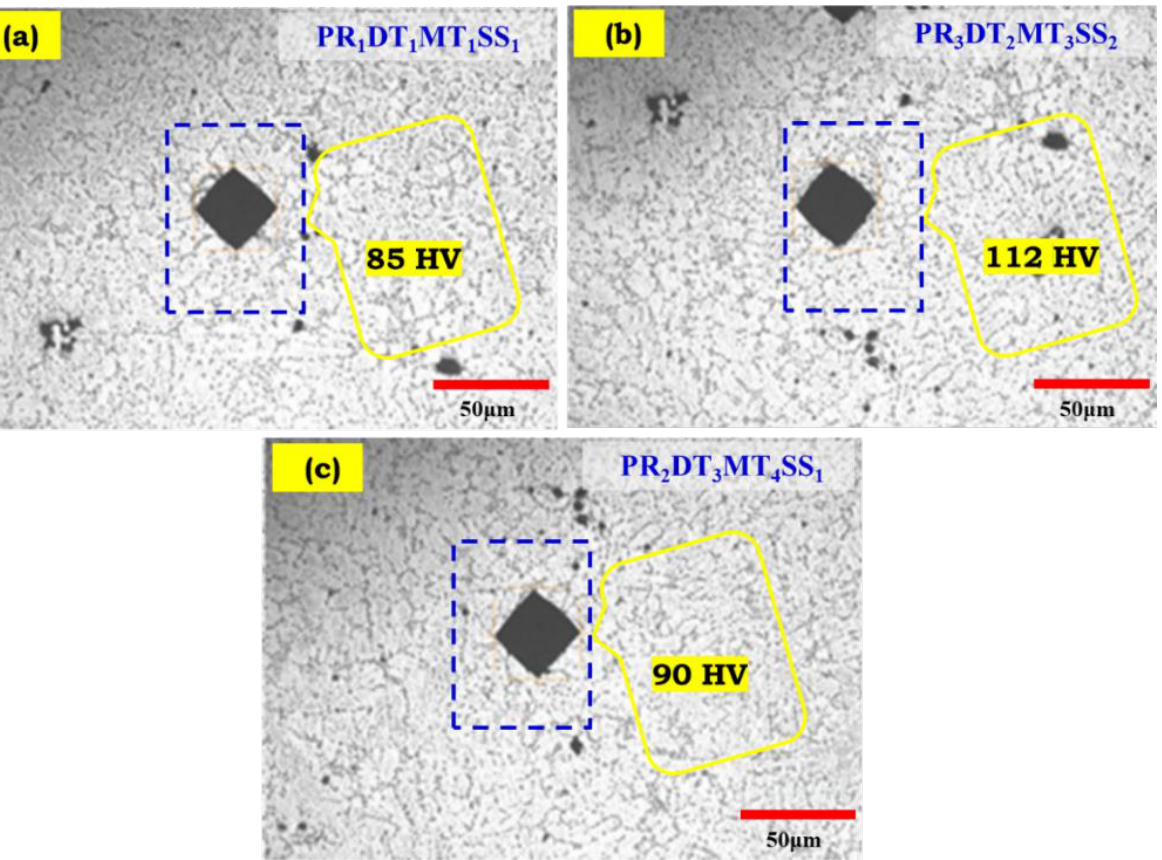
Figure 9. Microhardness indentation images of the present investigation. Where ( a ) PR 1 DT 1 MT 1 SS 1